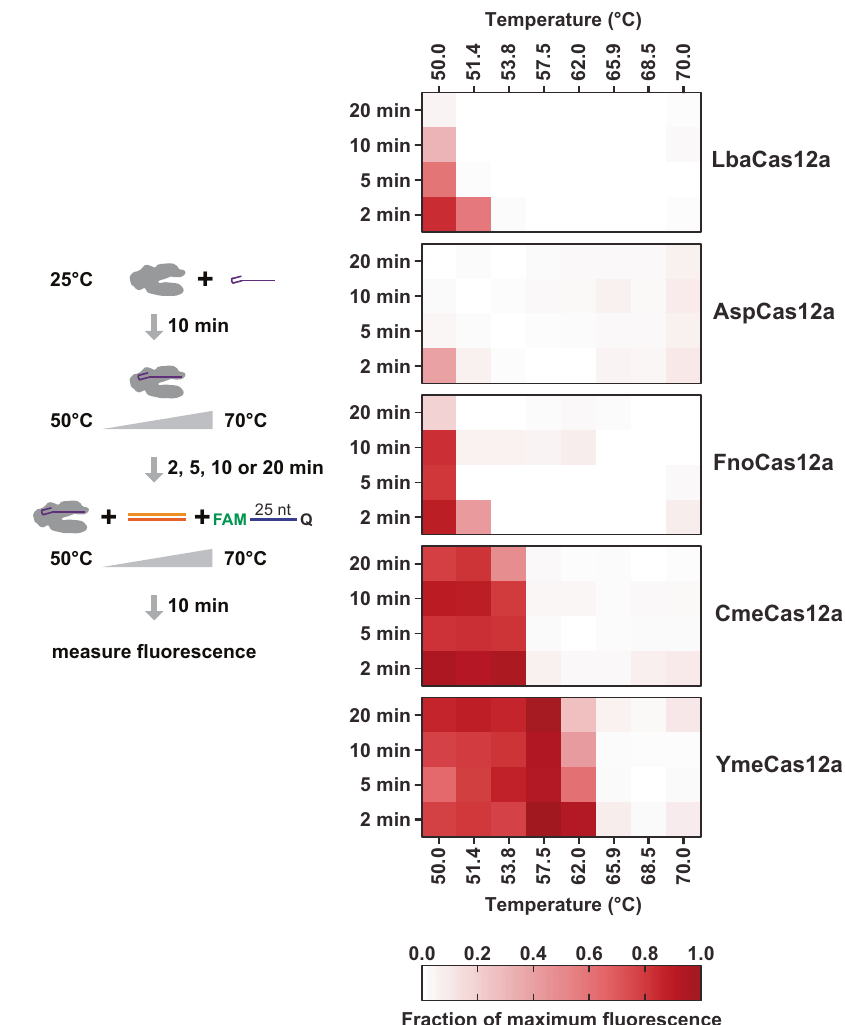
Fig. 8 High temperature trans nuclease activity initiated by DNA target cleavage. Cas12a RNPs were incubated at the temperatures indicated for either 2, 5, 10, or 20 min prior to the addition of target double-stranded DNA and a 25 nt single-stranded DNA reporter with 5 ′ fl uorophore and a 3 ′ quencher modi fi cations. Reactions were then incubated at the indicated temperature for 10 min and fl uorescence was measured at the end of the reaction. The measured values were averaged and divided by the maximum value of fl uorescence possible if all reporter DNA was cleaved in the assay. The intensity of the red color in the graphs corresponds to the fraction of maximum fl uorescence the Cas12a enzymes were able to generate for each time and temperature combination. Source data used to generate this graph is provided in Supplementary